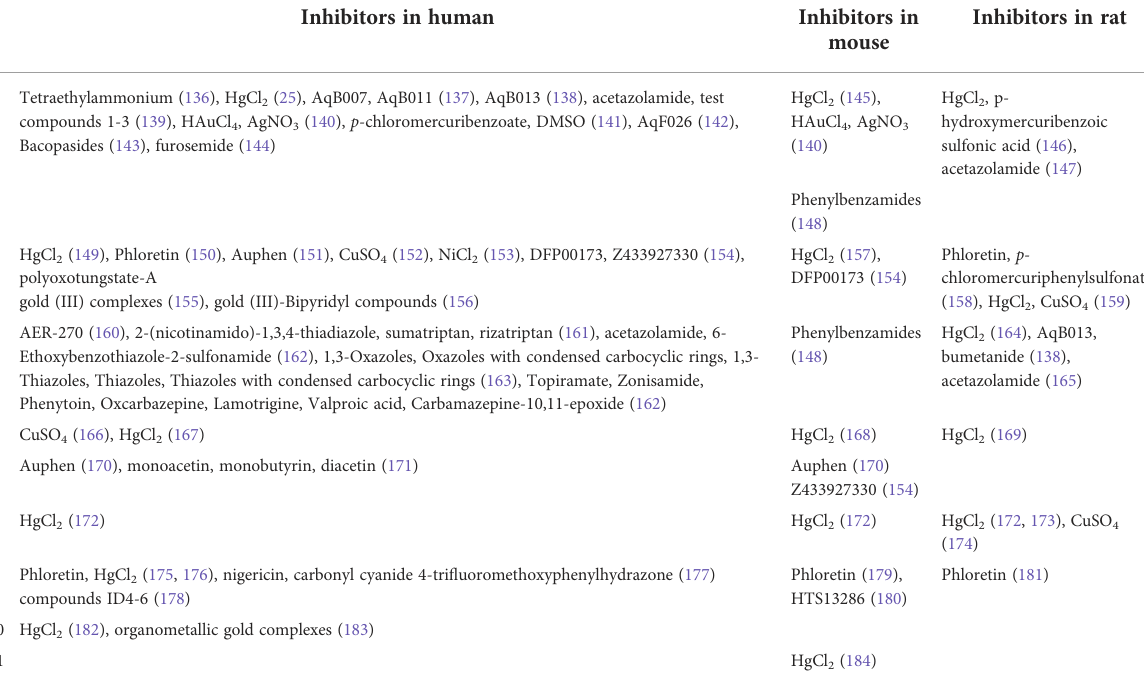
Inhibitors in rat mouse